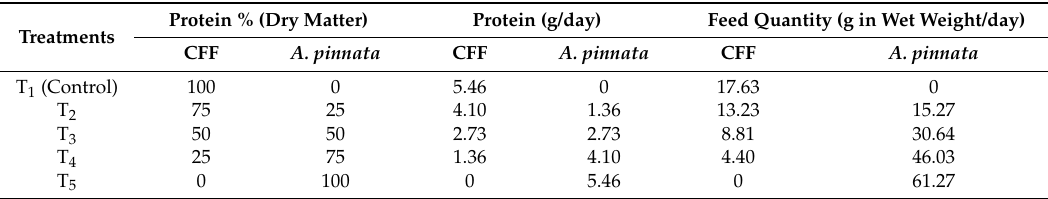
Table 4. Experimental design and feeding dose (at initial level) at different treatments. Treatments